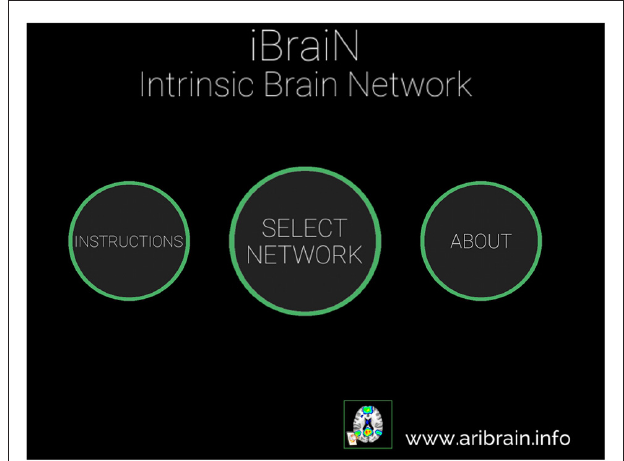
FIGURE 1 | Main window of the iBraiN2 application. By touching “Instructions”, user instructions appear for iBraiN2, by pressing “About” iBraiN2 authoring information appears, and by touching the “Select Network” button the application displays a menu to select a functional connectivity network (see Figure 2